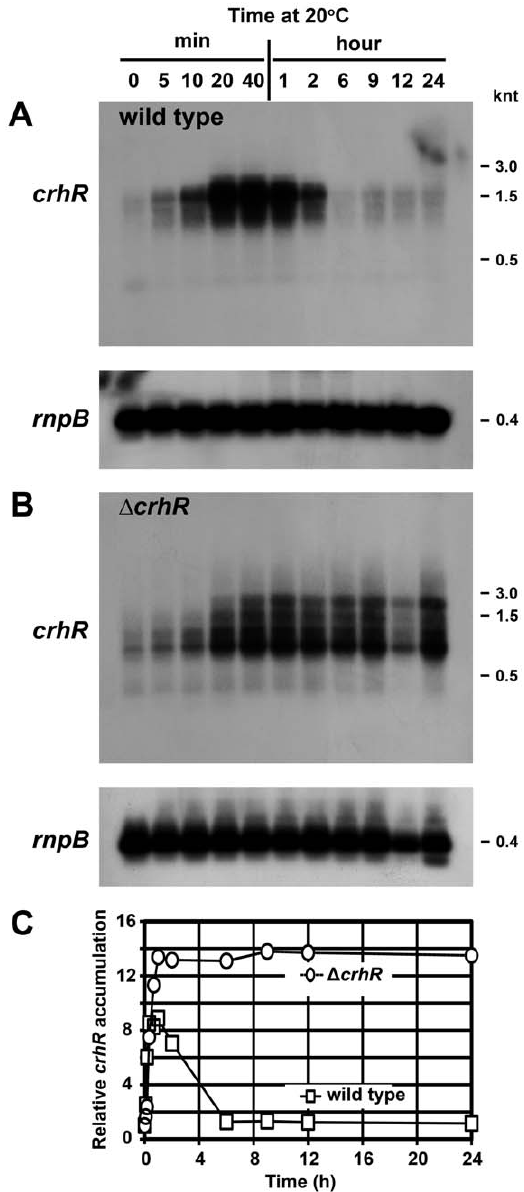
Figure 2. Time course of crhR transcript accumulation. Wild type ( A ) or D crhR mutant ( B ) Synechocystis were grown to mid-log phase at 30 u C at which time the cultures were transferred to 20 u C for the indicated times before harvesting. crhR transcript was detected in total RNA probed with a 93 bp Hinc II- Sac II internal fragment of crhR . The blots were stripped and probed with the Synechocystis rnpB gene as a control for RNA loading. C ) Quantification of crhR transcript levels. Transcript levels were quantified as described in Figure 1 and expressed as accumulation relative to crhR abundance observed in illuminated wild type cells grown at 30 u C (set to 1.0) serving as a reference for the fold-change values shown (Method S1). Open circles, D crhR ; open boxes, wild